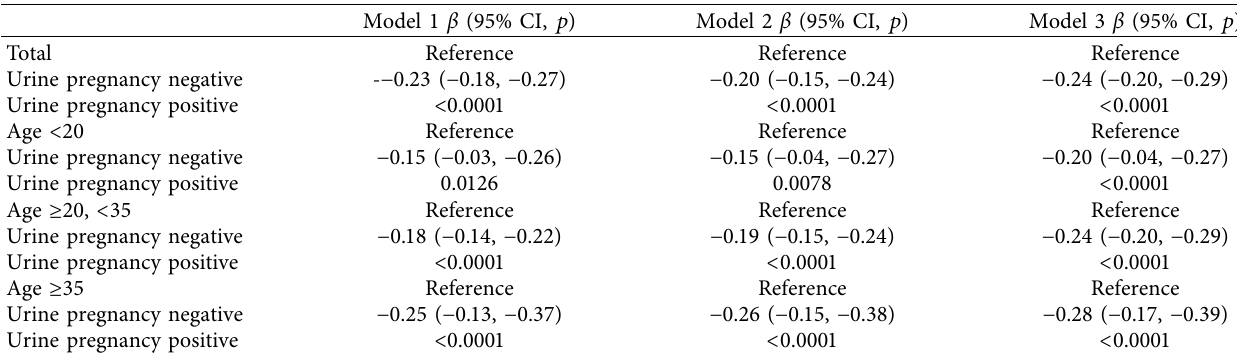
Table 2: Associations between urine pregnancy test and HbA1c (%) in nondiabetes